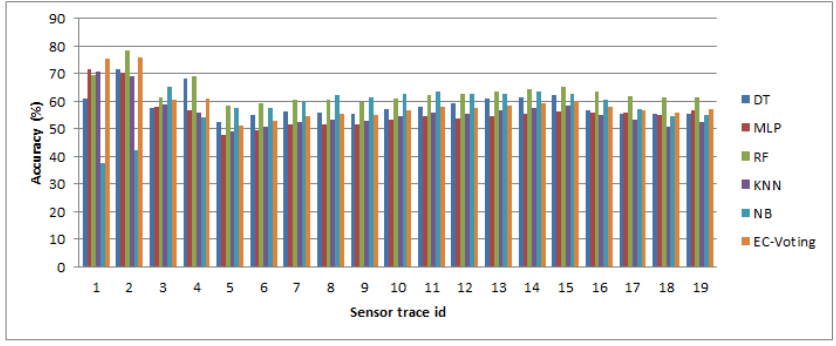
Figure 16. Transport mode detection accuracy using a 5 s kernel over different test sensor